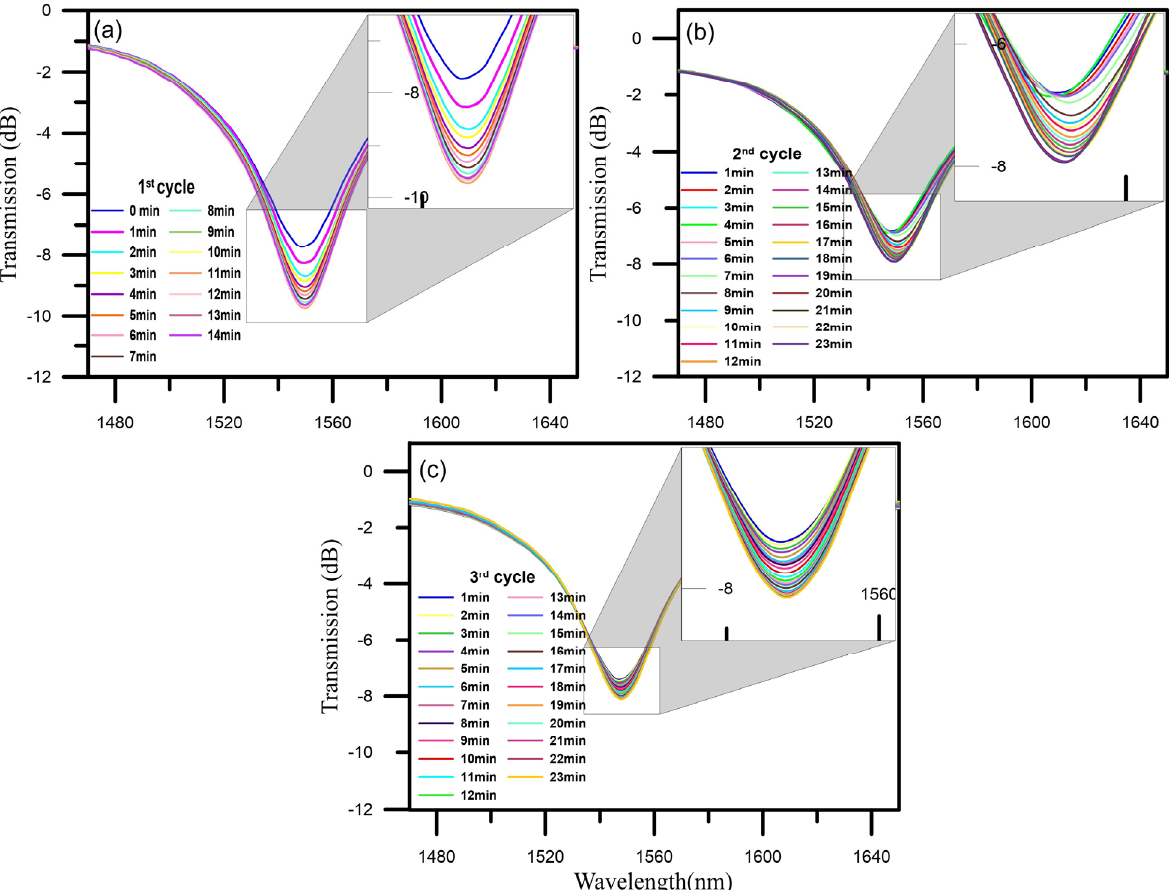
Figure 4. The spectra of CO 2 gas sensing. ( a ) First cycle spectra of CO 2 gas sensing; ( b ) Second cycle spectra of CO 2 gas sensing; ( c ) Third cycle spectra of CO 2 gas sensing. The insets represent magnified images of the